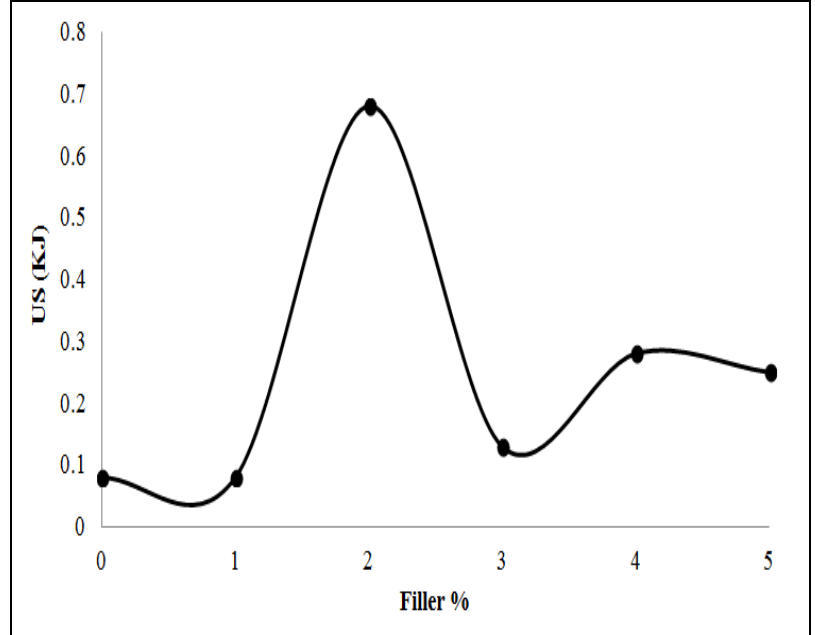
Fig.14: Fracture energy (KJ) with filler for all samples.